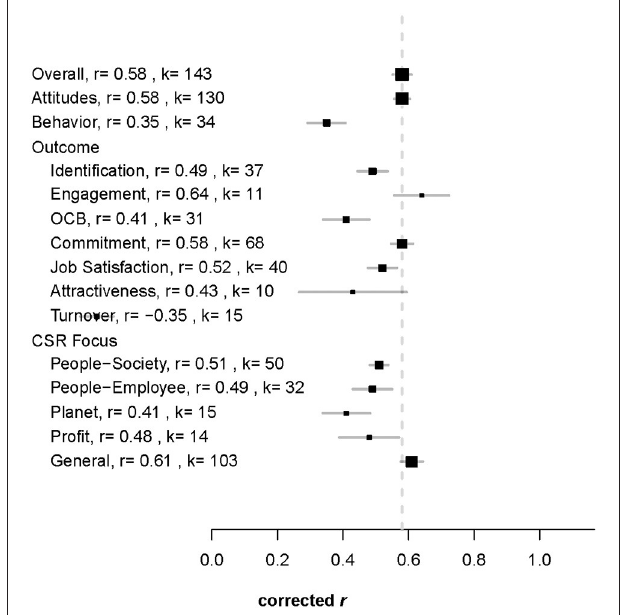
FIGURE 4 | Forest plot displaying effect sizes in relation to the average effect size. Outcomes and CSR dimensions, r, mean corrected effect size; k, number of